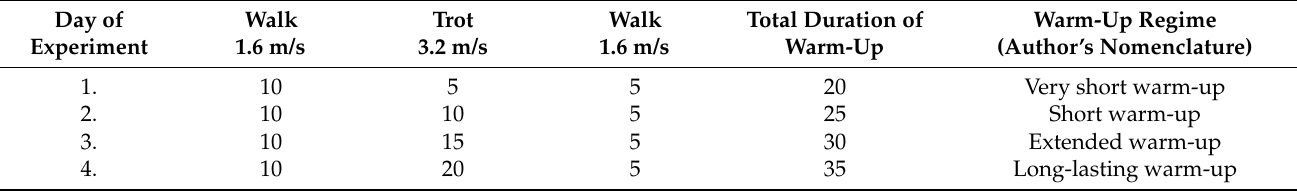
Table 2. Warm-up regime (min) on consecutive experiment